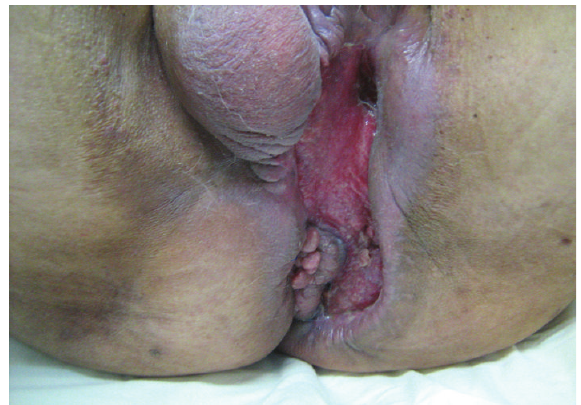
Figure 5: Image of the surgical wound four weeks after the initial operation showing that the gas gangrene has completely resolved, the wide wound is reduced, and good granulation is